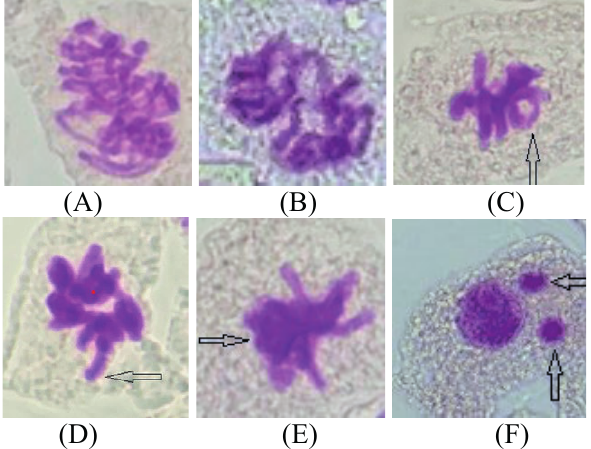
Figure 1. Some cellular aberrations identifi ed in meristematic cells of A. cepa exposed to Brilliant Blue and Sunset Yellow food dyes: irregular kinetics of chromosomes (A,B); ring chromosome (C); laggard chromosome (D); sticky chromosomes (E); cell with two micronuclei (F).